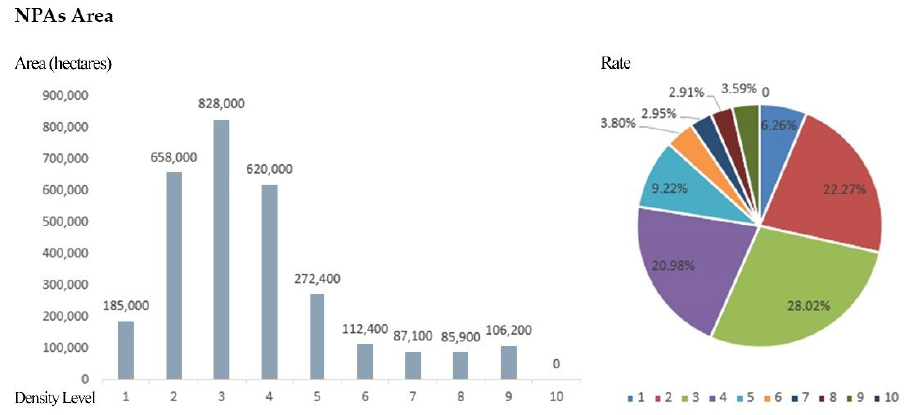
Figure 11. Statistics regarding the area of NPAs at different levels.